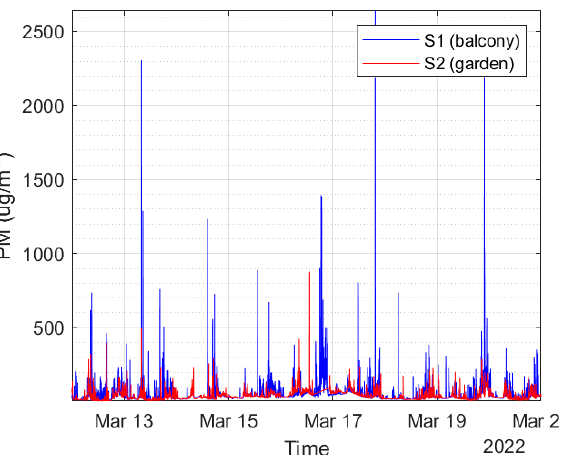
Figure 5. Measurement of PM10 in a small village on the balcony of the family house (blue line) and in the garden (red line).